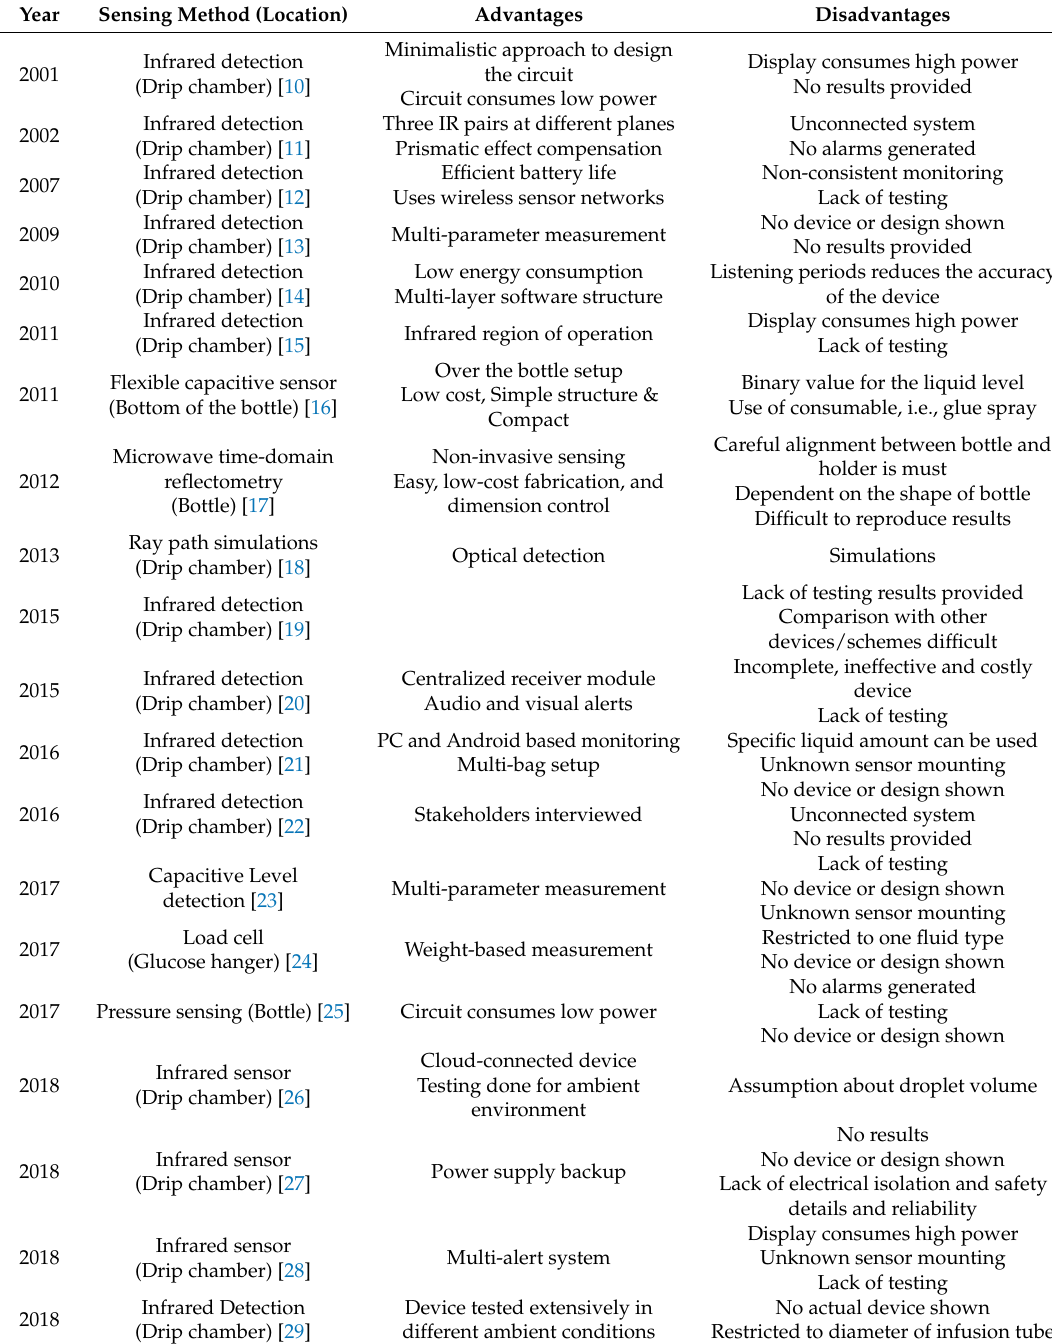
Table 1. Summary of Intravenous (IV) drip monitoring techniques, with their advantages and